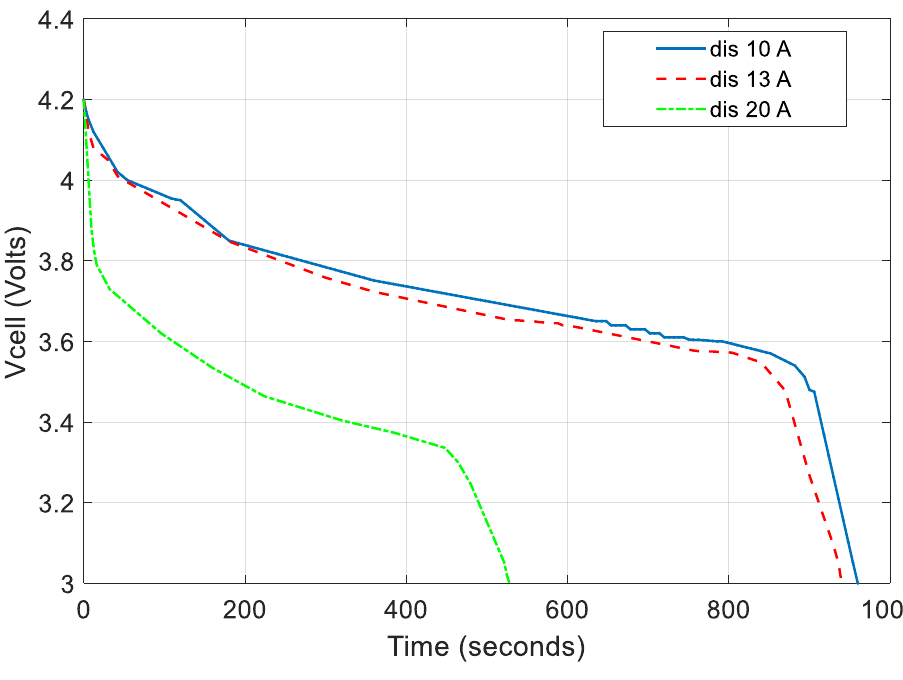
Figure 6. Cell discharge results.